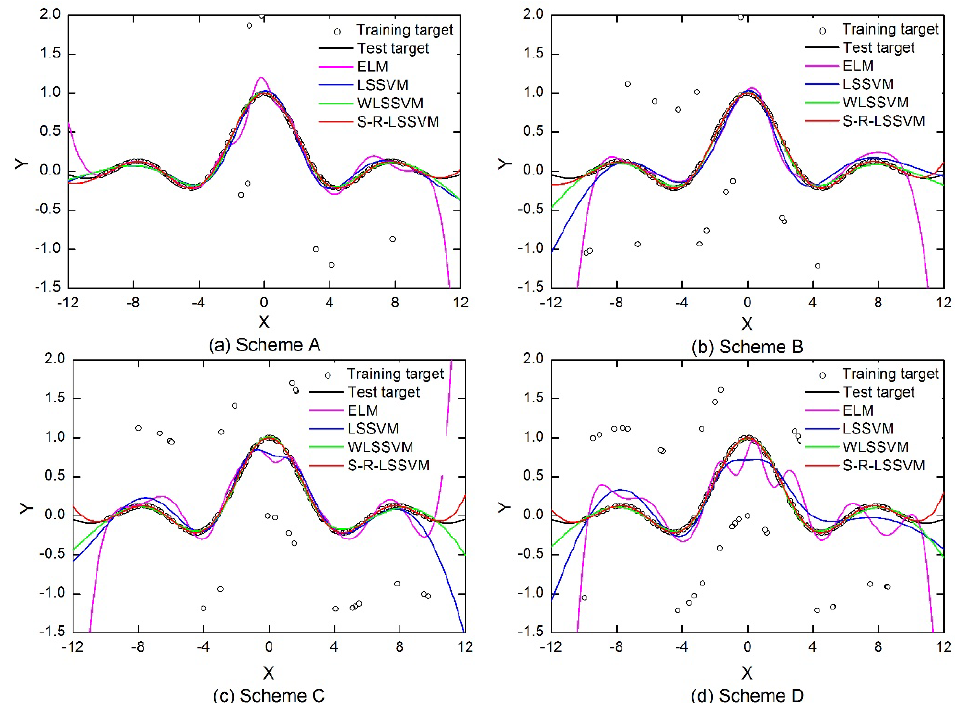
Figure 4. Prediction results of the SinC function under the four schemes to add noises and outliers. Table 1. Comparison of the test results for SinC function. ELM: extreme learning machine,